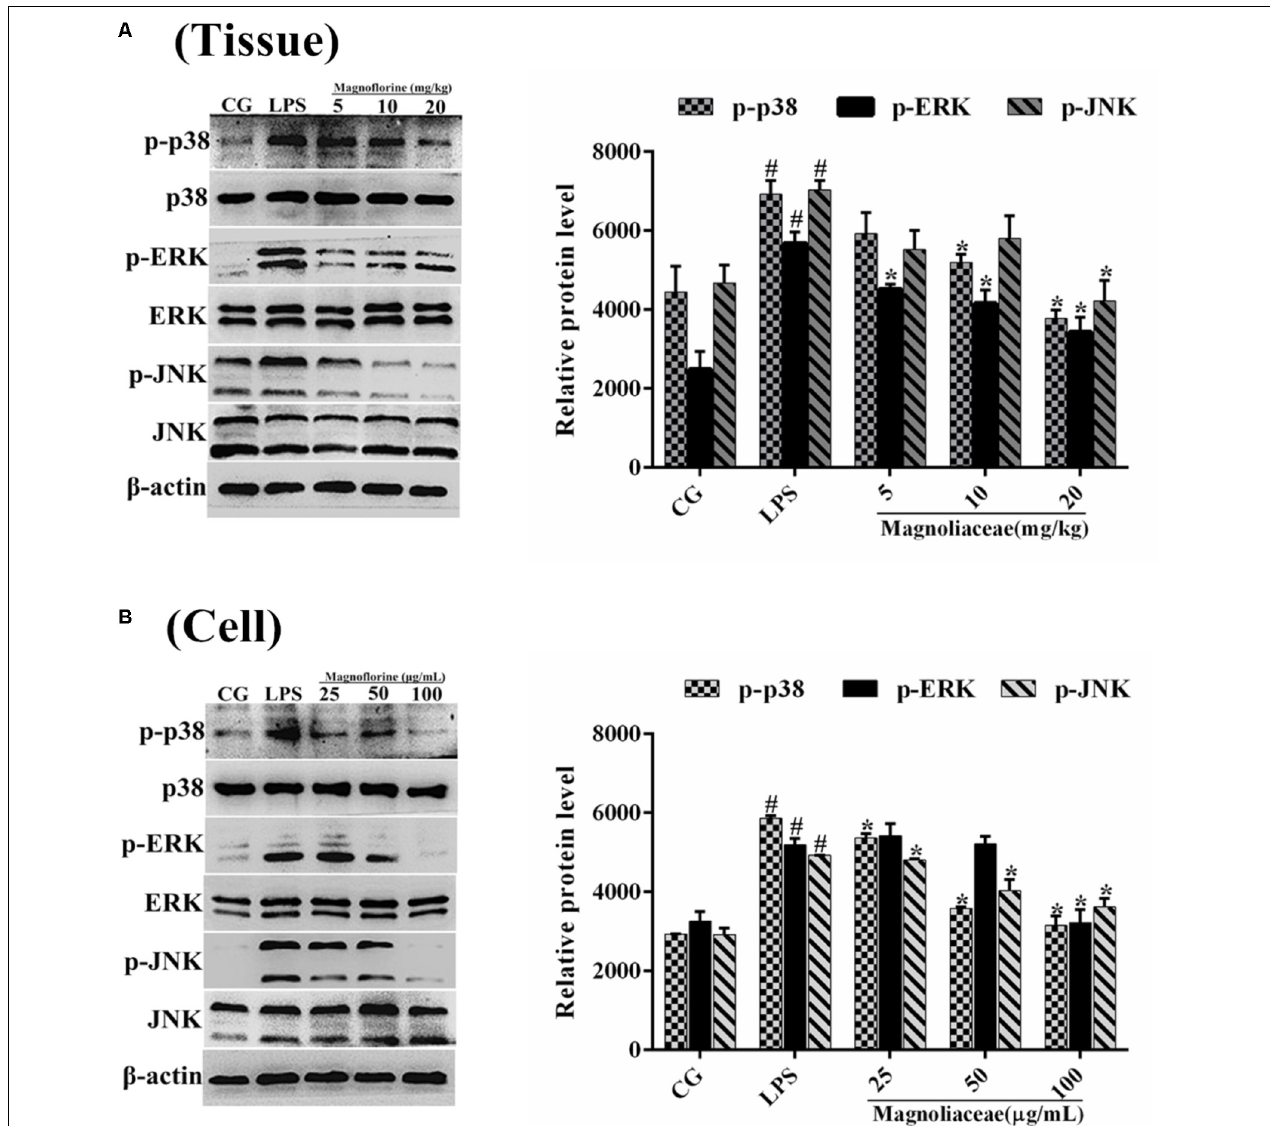
FIGURE 8 | Effects of magnoflorine on the MAPK pathway activation. (A) The expression levels of p38, ERK, and JNK proteins in lung tissues. (B) The expression levels of p38, ERK, and JNK proteins in RAW264.7 cells. β -actin was used as the control. CG is the control group. LPS is the LPS-stimulated group. The data represent the mean ± S.E.M. ANOVA, p < 0.0001, post hoc # p < 0.05 vs. control group, ∗ p < 0.05 vs. LPS